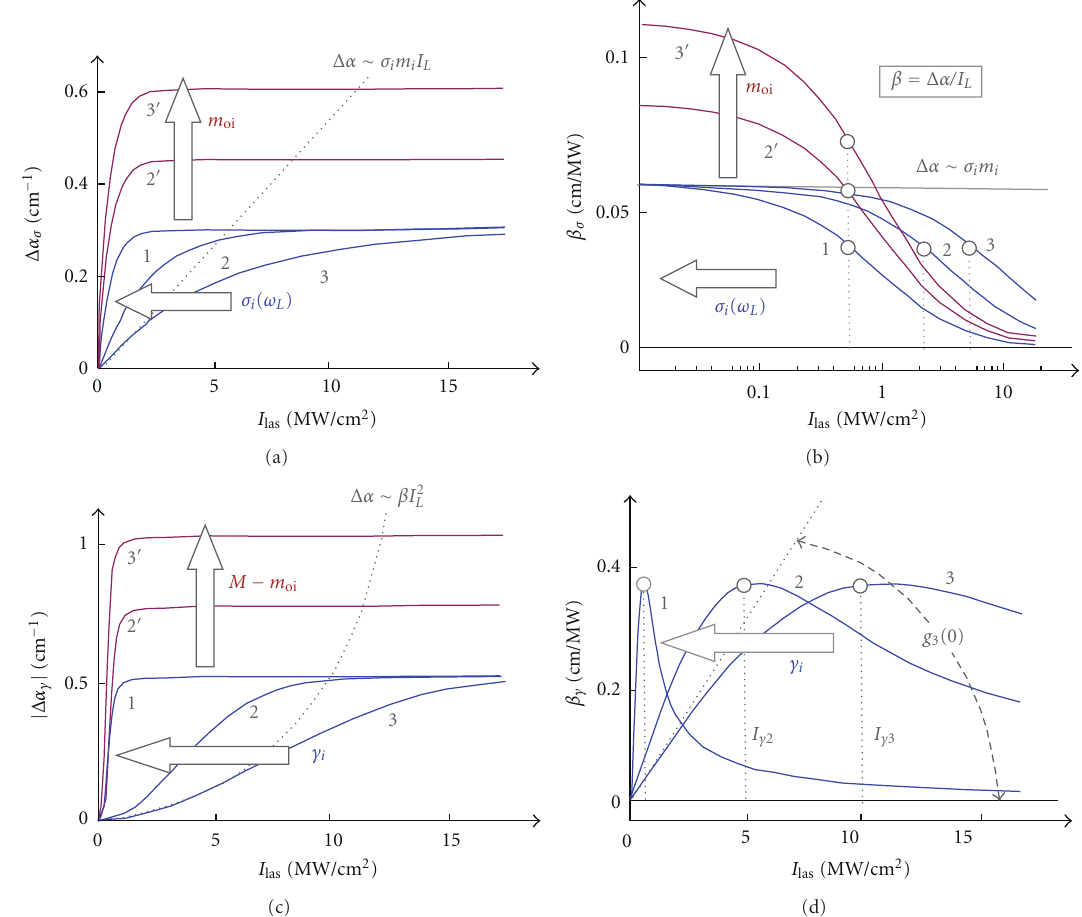
Figure 5: Comparison of the light-intensity dynamics of σ -DLSS (laser photoionization of DL, (16)) and of γ -DLSS (28) (capture of nonequilibrium two-photon generated carriers). Separation of the components of di ff erent DL absorption bands: (a) and (b) based on the di ff erence of laser photon capture cross-sections σ , that is, on photoactivity of the centers; (c) and (d) based on the di ff erence of coe ffi cients γ of carriers capture, that is, on electroactivity of the centers. The sequence of curves 1, 2, and 3 corresponds to the reduction of capture cross-sections σ ( ω L ) for σ -DLSS, or coe ffi cients γ of carrier capture ( γ -DLSS). The sequence of curves 1, 2 (cid:3) , and 3 (cid:3) reflects the influence of initial population m 0 and “vacancies” M − m 0 of the centers,